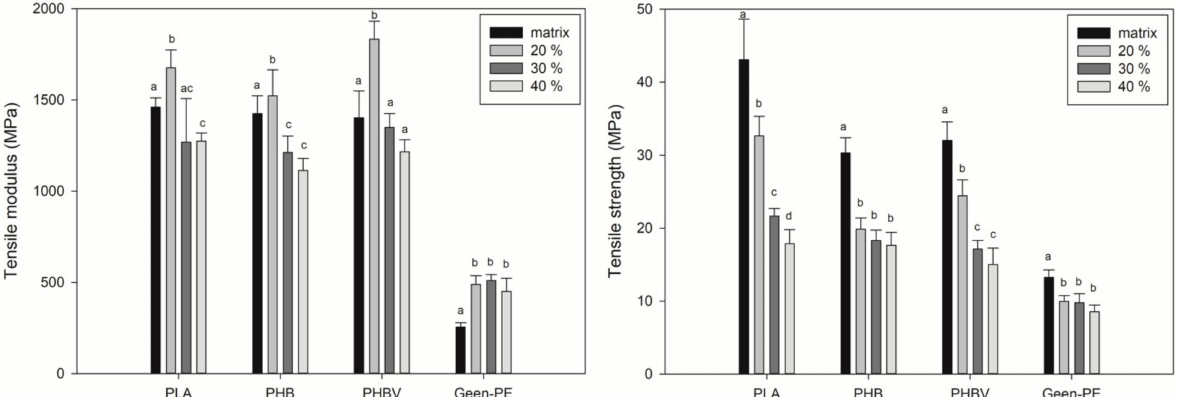
Figure 4. Tensile properties of the biocomposites. Different letters (a–c) on the bars indicate significant differences ( p <